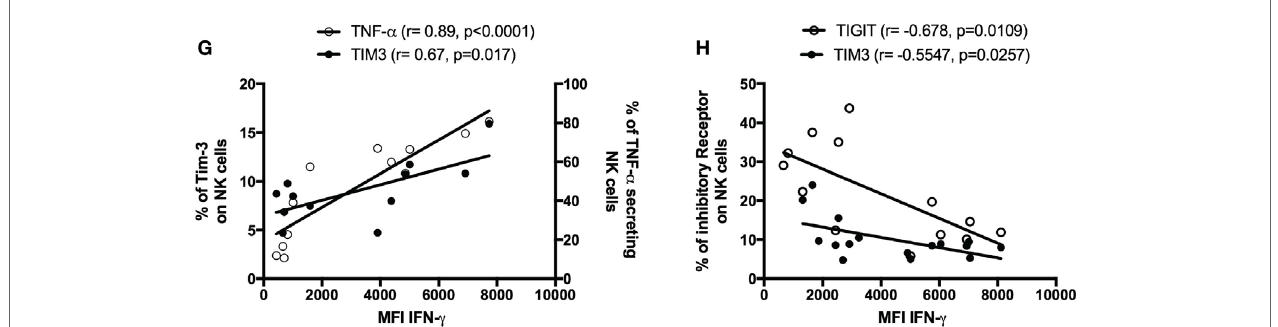
FigUre 3 | Tim-3 expression and adaptive natural killer (NK) cells during human immunodeficiency virus (HIV) infection. (a) Induction of CD57 + NKG2C + NK cells during HIV therapy. Untreated HIV patients were followed longitudinally before and after the initiation of antiretroviral treatment (48 weeks). Representative zebra plots of adaptive markers and inhibitory receptors expression on total NK cells (CD3 neg CD56 + ) during highly active antiretroviral therapy (HAART) follow-up. (B) Inhibitory receptors expression of mature NK cells during HIV infection. Fifteen HIV infected patients were monitored before and after HIV treatment. Tim-3, T-bet, and Eomes modulation in NK cells were not statistically significant modulated by HAART. The median values were compared using a Wilcoxon matched-pairs signed rank test (* p < 0.05, ** p < 0.01, *** p < 0.001, and **** p < 0.0001). (c) Downmodulation of Tim-3 but preservation of NKG2C on CD57 + NK cells during HIV infection. The frequencies of Tim-3 and NKG2C in CD57 − and CD57 + NK cells (gated as viable CD56 + CD3 neg cells) were studied in our cross-sectional HIV cohort (Malaysia) and compared with healthy donors from Singapore (first column) or Malaysia (second column). (D) Increased expression of inhibitory receptors and transcription factor (TF) expression in CD57 + NK cells during HIV infection. The frequencies of inhibitory receptors and TF in CD57 + NK cells (gated as viable CD56 + CD3 neg cells) were normalized to obtain a mean row Z -score for each marker. A cold-to-hot heat map represented the relative expression of molecules in each patient group (age did not impact on the expression of most of these molecules and was not included here to simplify the representation). (e) Tim-3 expression, immune activation, and inhibitory receptors. Soluble CD14 correlated negatively with Tim-3 expression on mature CD57 + NK cells from HIV-infected and HIV-non-infected individuals ( n = 119). The loss of Tim-3 expression is also coupled with acquisition of Ceacam-1 on CD57 + NK cells from HIV-infected and HIV-non-infected individuals ( n = 128). The acquisition of Tim-3 was positively associated with T-bet ( n = 145) and inhibitory receptors including CD160 ( n = 145) and T-cell immuno-receptor with Ig and ITIM domain (TIGIT) ( n = 145) in all donors. We used the non-parametric Spearman rank-order test to compare correlation between Tim-3 and sCD14 or proteins expression on CD57 + NK cells. We reported r -values and p -values. Analysis with * p < 0.05, ** p < 0.01, and *** p < 0.001 were considered significantly different between the groups. (F) NK cells functions and inhibitory receptors expression during HIV infection. Representation of a combined phenotype